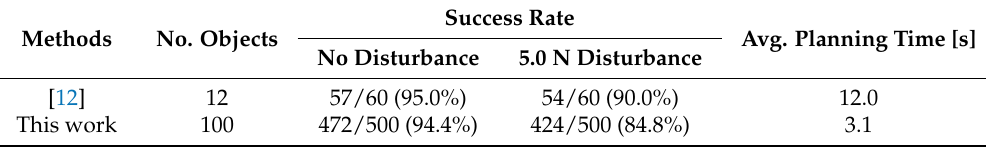
Table 2. Comparison of the